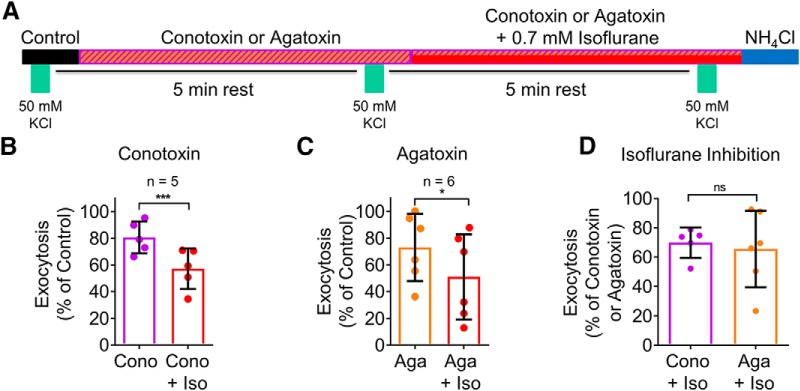
Isoflurane inhibits elevated KCl-evoked SV exocytosis mediated by CaV2.1 or CaV2.2 in dopaminergic neurons. A, Schematic of protocol using depolarizing pulses of 50 mM KCl with 1 μM conotoxin and 0.7 mM isoflurane or with 400 nM agatoxin and 0.7 mM isoflurane in dopaminergic neurons. B, Mean values of vMAT2-pHluorin response amplitudes in conotoxin and conotoxin + isoflurane treated dopaminergic neurons stimulated with elevated KCl; ***p < 0.001 by two-tailed paired t test. C, Mean values of vMAT2-pHluorin response amplitudes in agatoxin and agatoxin + isoflurane treated dopaminergic neurons stimulated with elevated KCl; *p < 0.05 by two-tailed paired t test. D, Comparison of the effect of isoflurane on CaV2.1 and CaV2.2 mediated elevated KCl-evoked exocytosis. ns, not significant by one-tailed t test.